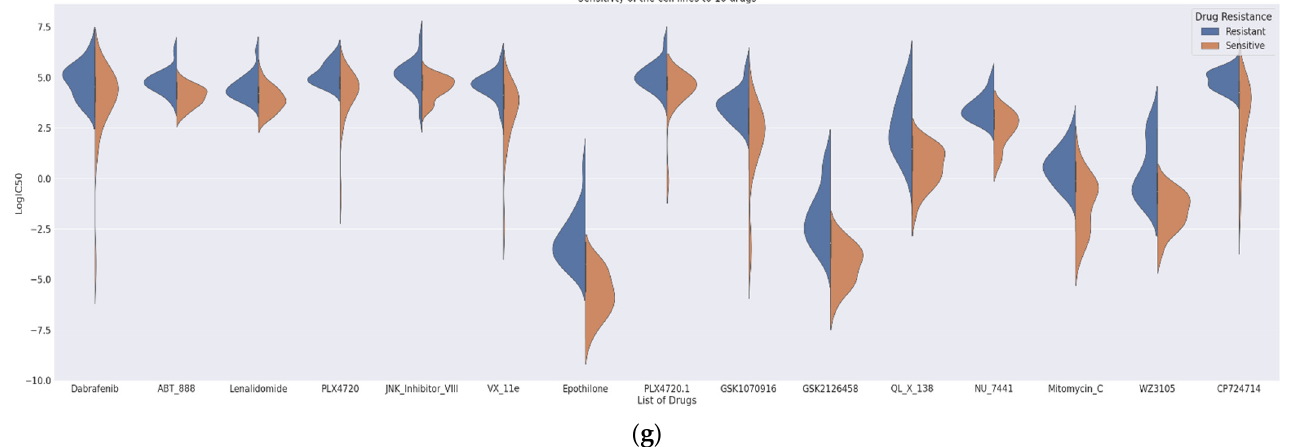
Figure 4. Performance of DCNN-DR using various metrics. ( a ) PCC for individual drugs. ( b ) Mean squared error of each drug. ( c ) Performance evaluation of the model using r2_squared error as a metric for six cancer drugs. ( d ) Box plot showing the accuracy, sensitivity and specificity of classification for all drugs. ( e ) AUC of different techniques for docetaxel and ( f ) gemcitabine. ( g ) Violin graph representing the sensitivity and resistance of cell-line samples for fifteen cancer drugs.